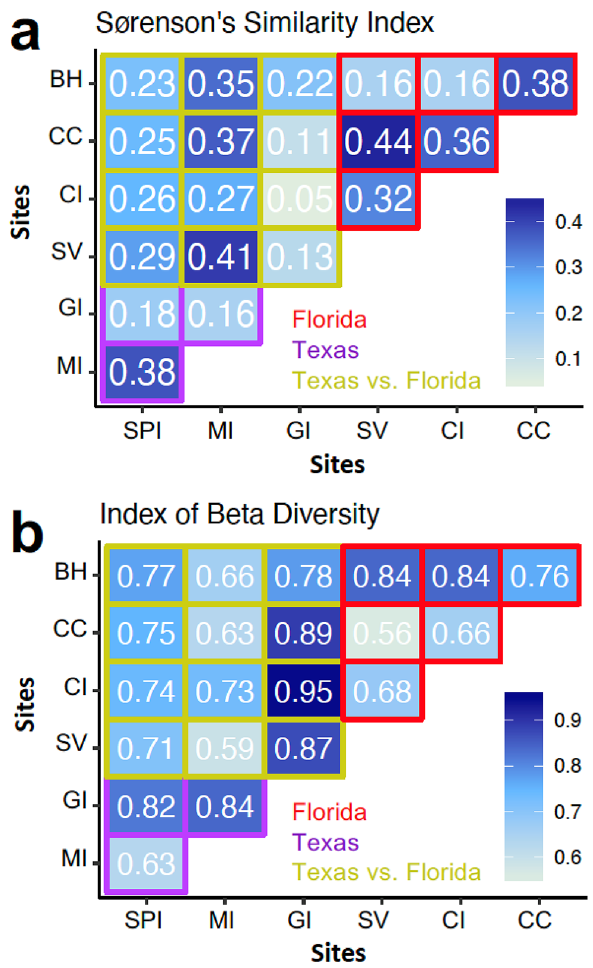
Figure 5. ( a ) Sørenson’s similarity index and ( b ) index of beta diversity 29 for Texas and Florida collection sites based on ITS rDNA T-RFLP